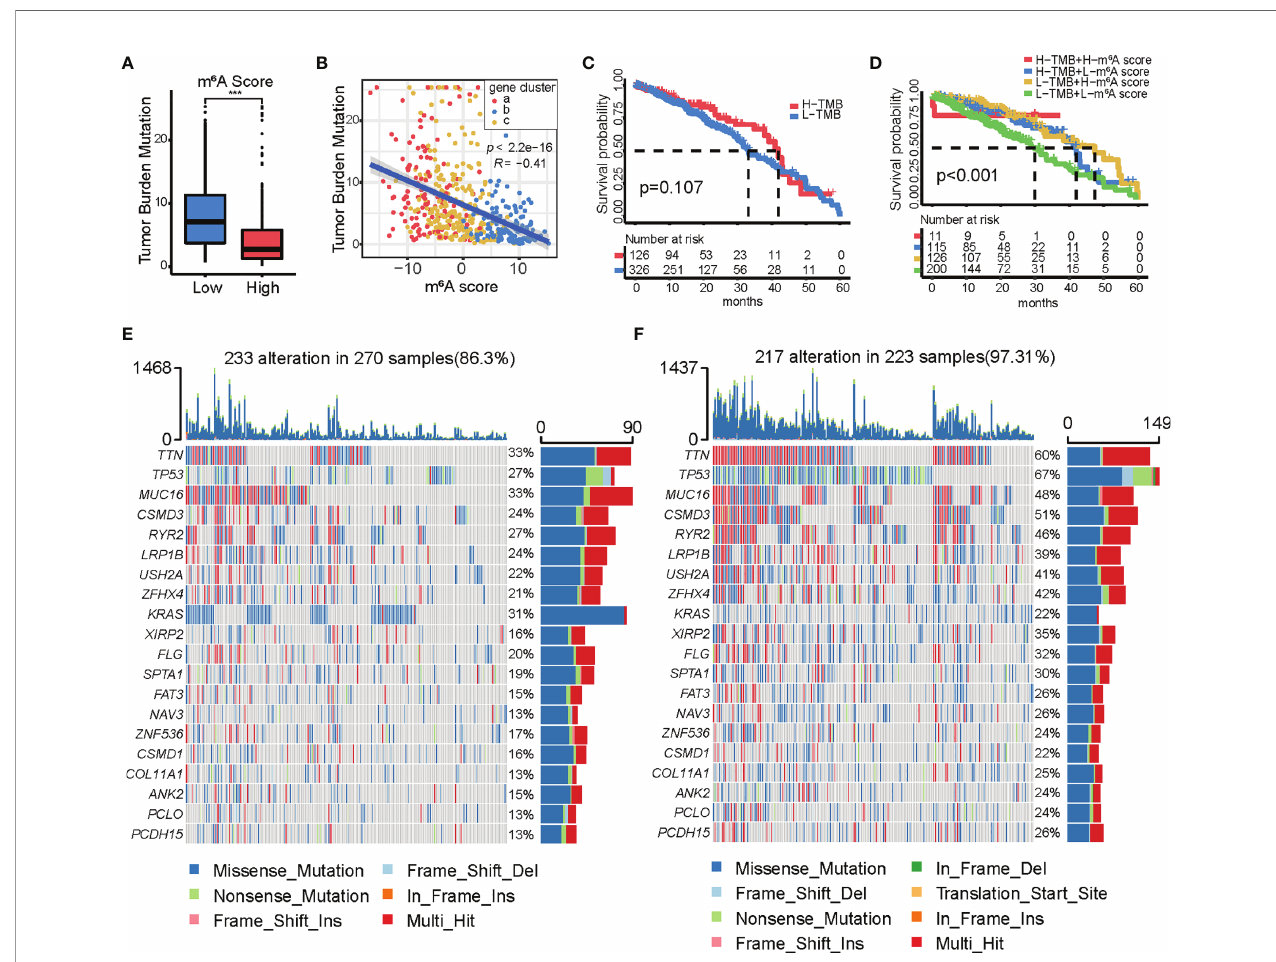
FIGURE 6 | Characteristics of m 6 A modi fi cation in tumor mutation burden (TMB). (A) Differences in TMB distribution between the high and low m 6 A score groups. (B) Correlation between TMB and m 6 A score. (C) Kaplan-Meier curves showing the differences in survival between the high ( n = 126) and low ( n = 326) TMB groups. Log-rank test, p = 0.107. (D) Survival analyses for subgroup patients strati fi ed by both m 6 A score and TMB using Kaplan-Meier curves. H, high; L, low. TMB, tumor mutation burden. Log-rank test, p < 0.001. (E, F) Waterfall plot of tumor somatic mutations in patients with high (E) and low (F) m 6 A score. Each column represents each individual patient. The upper bar plot represents TMB. The number on the right represents the mutation frequency in each regulator. The bar graph on the right shows the proportion of each variant type. The stacked bar chart below shows the conversion of each